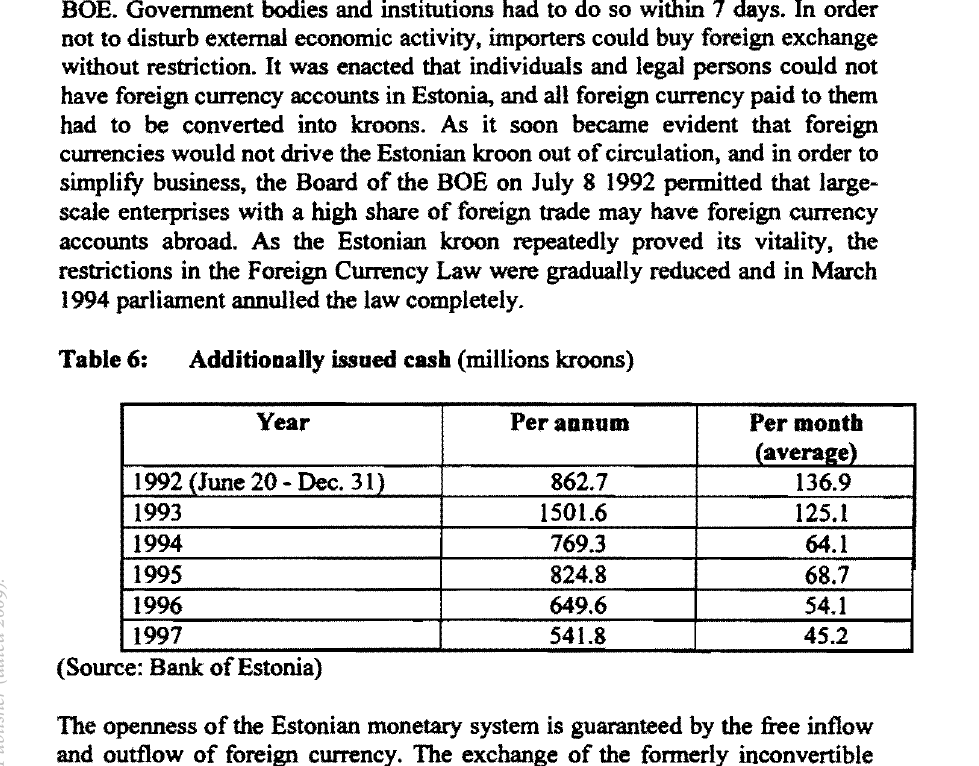
AdditioDally issued cash (millions